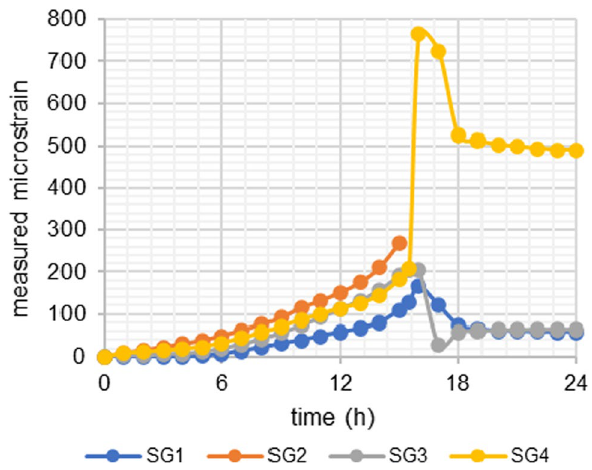
Fig. 12 Measured strains in